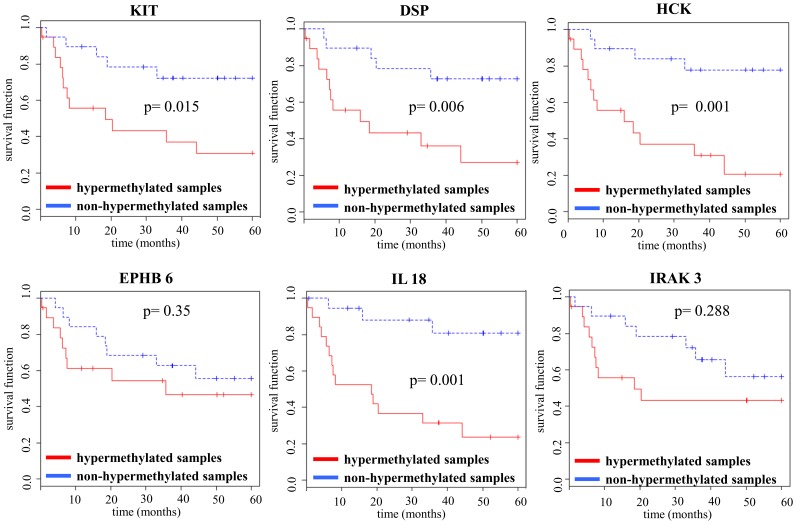
Hypermethylated genes associated with decreased survival rate in melanoma patients.The Kaplan-Meier curves for genes (DSP, EPHB6, HCK, IL18, IRAK3 and KIT) whose hypermethylation was associated with a lower overall survival rate (OS); the Cox proportional univariate approach was performed on each gene to test whether a methylation status of a particular gene significantly influences the survival at the p<0.05 level.